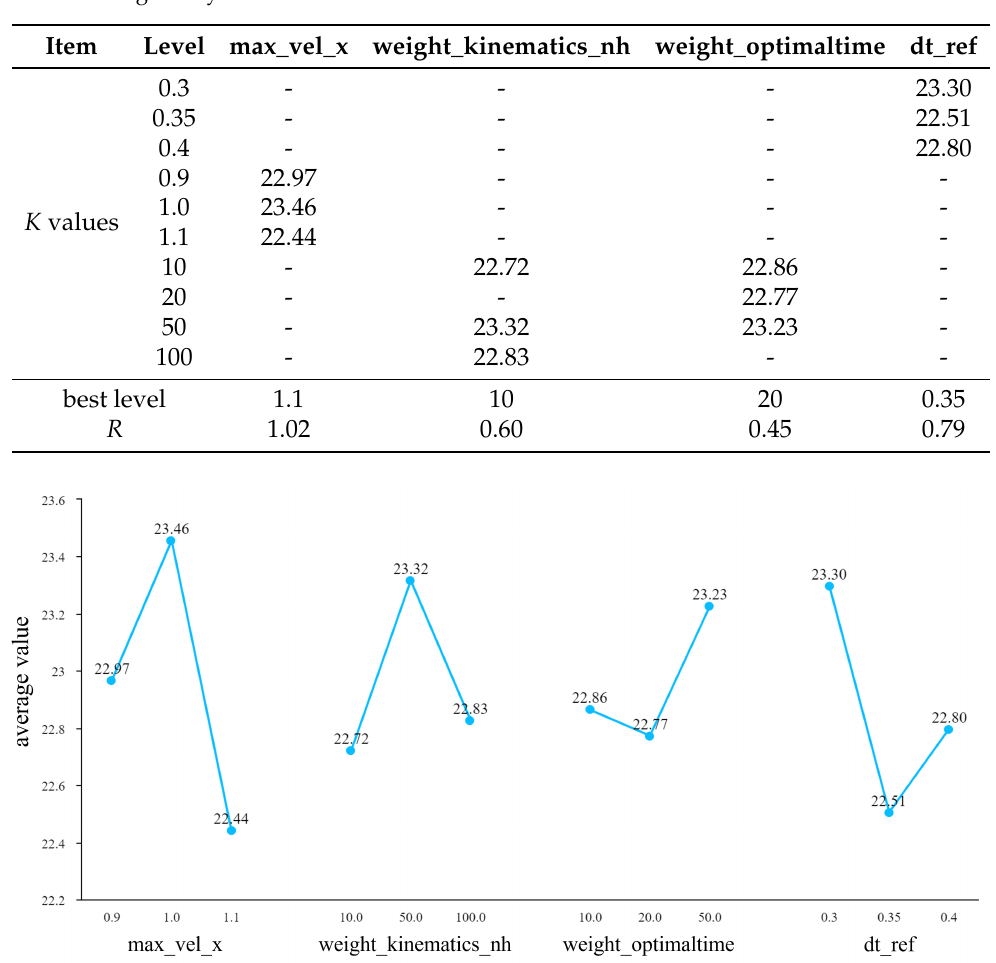
Table 5. Range analysis.